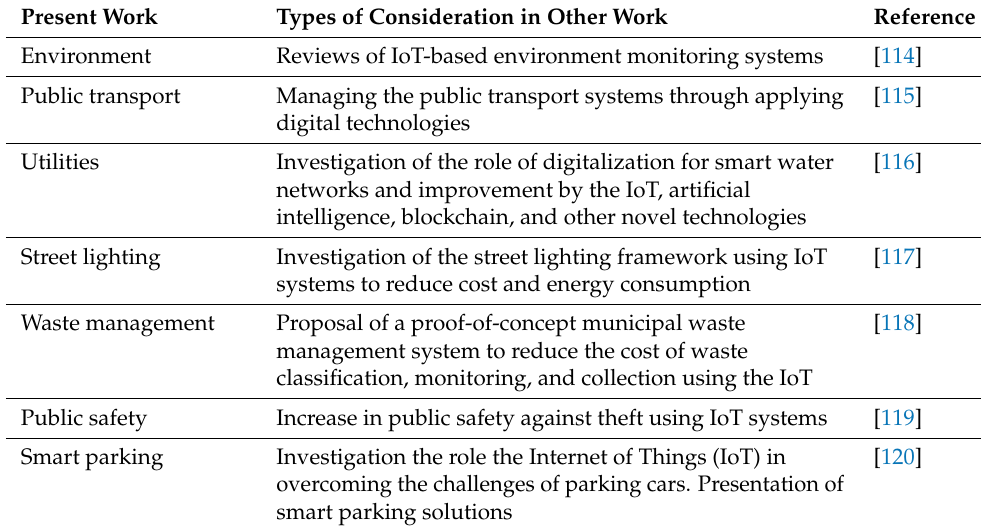
Table 2. A comparison of the results of this work and those of previous